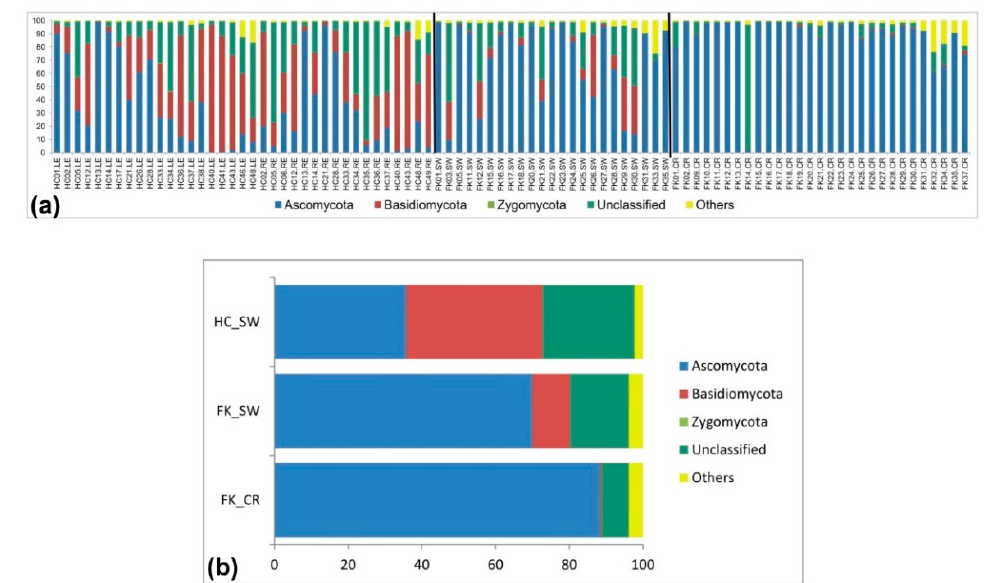
Figure 2. Abundance (%) ( a ) and average abundance (%) of fungal phyla ( b ) from microbiomes of conjunctival swabs of healthy controls (HC-SW, n = 37), conjunctival swabs of fungal keratitis patients (FK-SW, n = 23), and corneal scrapings of fungal keratitis patients (FK-CR, n = 29). At the genus level, only 62.31% of the reads (23138204 / 37131168) across all three cohorts